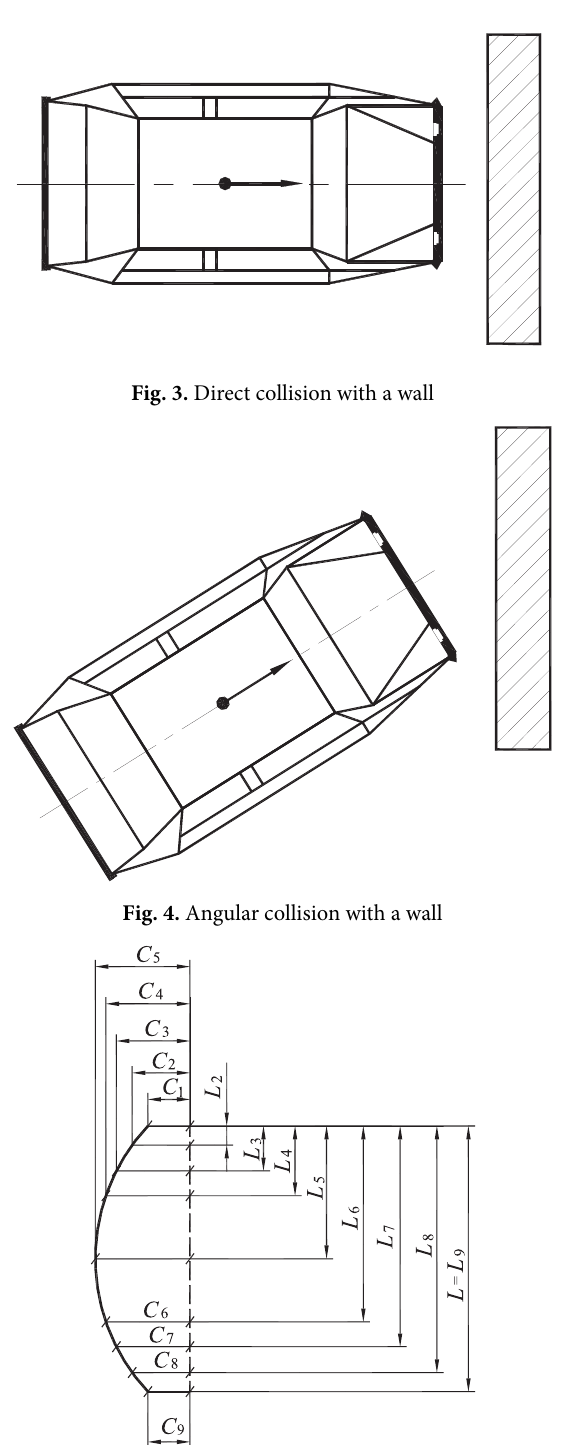
Fig. 5. Scheme of car deformation measurement points aft er collision with a tree, a bollard,